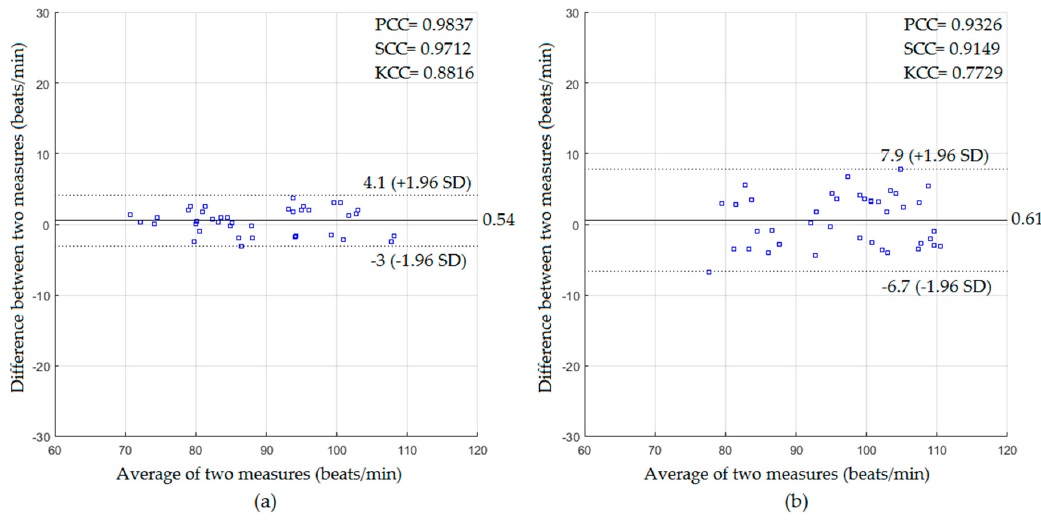
Figure 6. The statistics of HR measurements obtained in a well-lit environment for participants ( a ) without a blanket; ( b ) with a blanket.